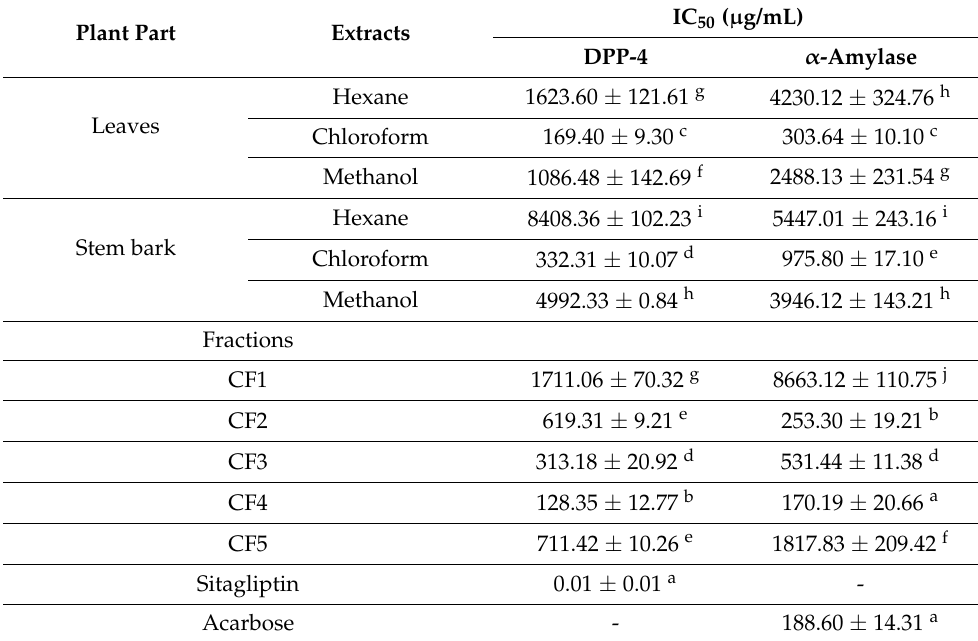
Table 2. DPP-4 and α -Amylase inhibitory activities of various M. glabra extracts and the chloroform leaves’